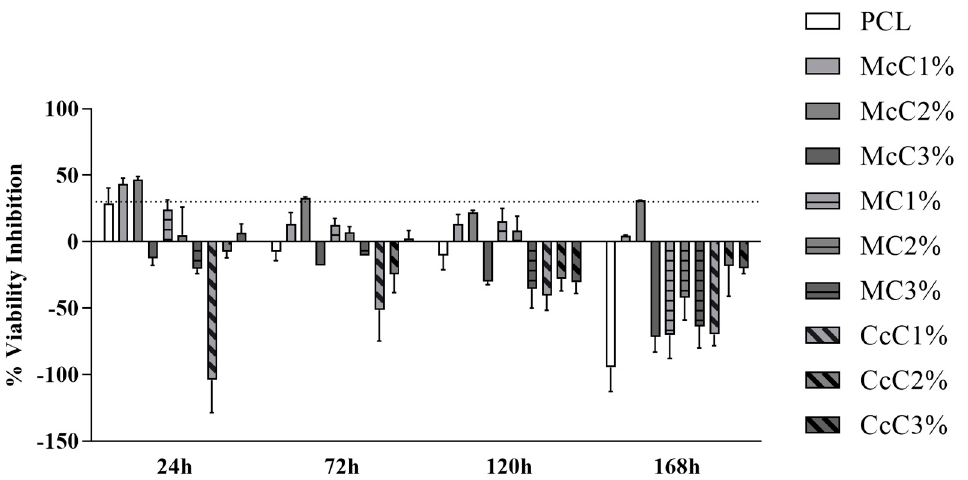
Figure 8. Percentage of inhibition of cell viability of each scaffold in contact with the hDPSCs. The dashed line represents the 30% inhibition limit, above which the effect is considered cytotoxic according to the ISO 10993-5:2009 guidelines.